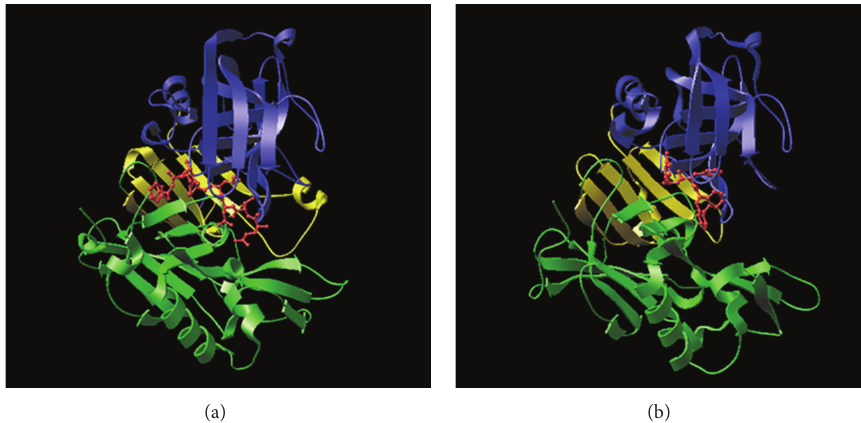
Figure 3: Chain A of crystal structures of BACE1 (a) and BACE2 (b). In both structures, the N-terminal, inter-, and C-terminal domains are coloured blue, yellow, and green, respectively. The ligands are displayed with “Ball and Stick” and red colour.